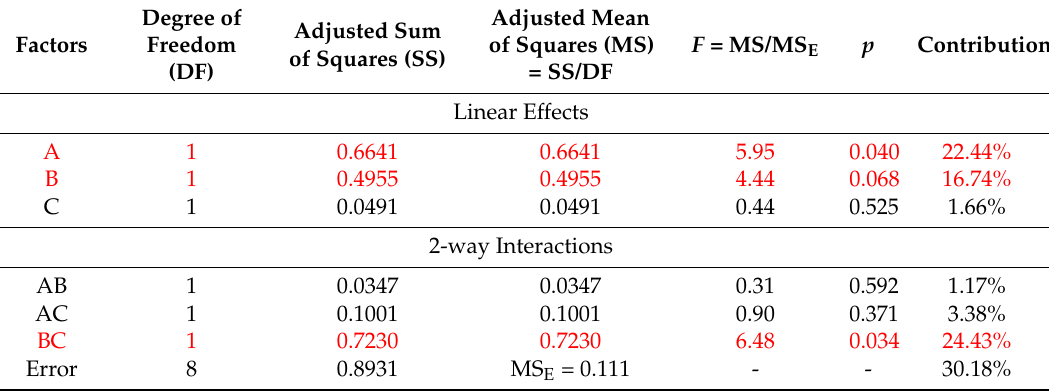
Table 4. Analysis of variance for I 2D / I G using adjusted SS for the tests. The texts marked in red represent statistically-significant